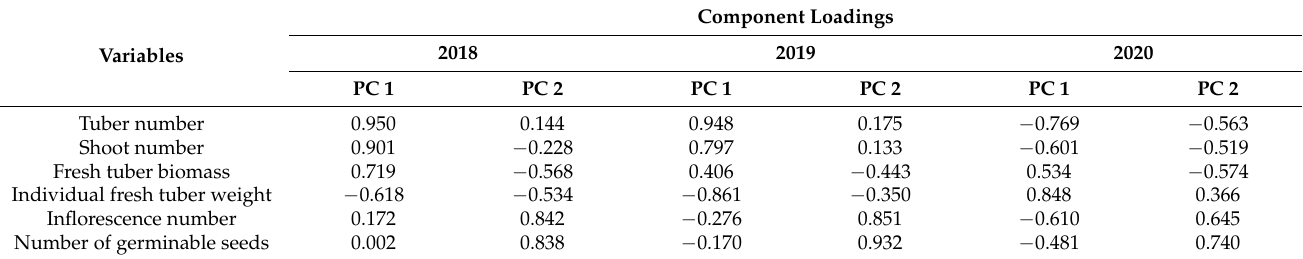
Table 3. Component loadings of the first two principal components (PCs) from the categorical principal component analysis (CATPCA) on the morphological variables for the three experimental